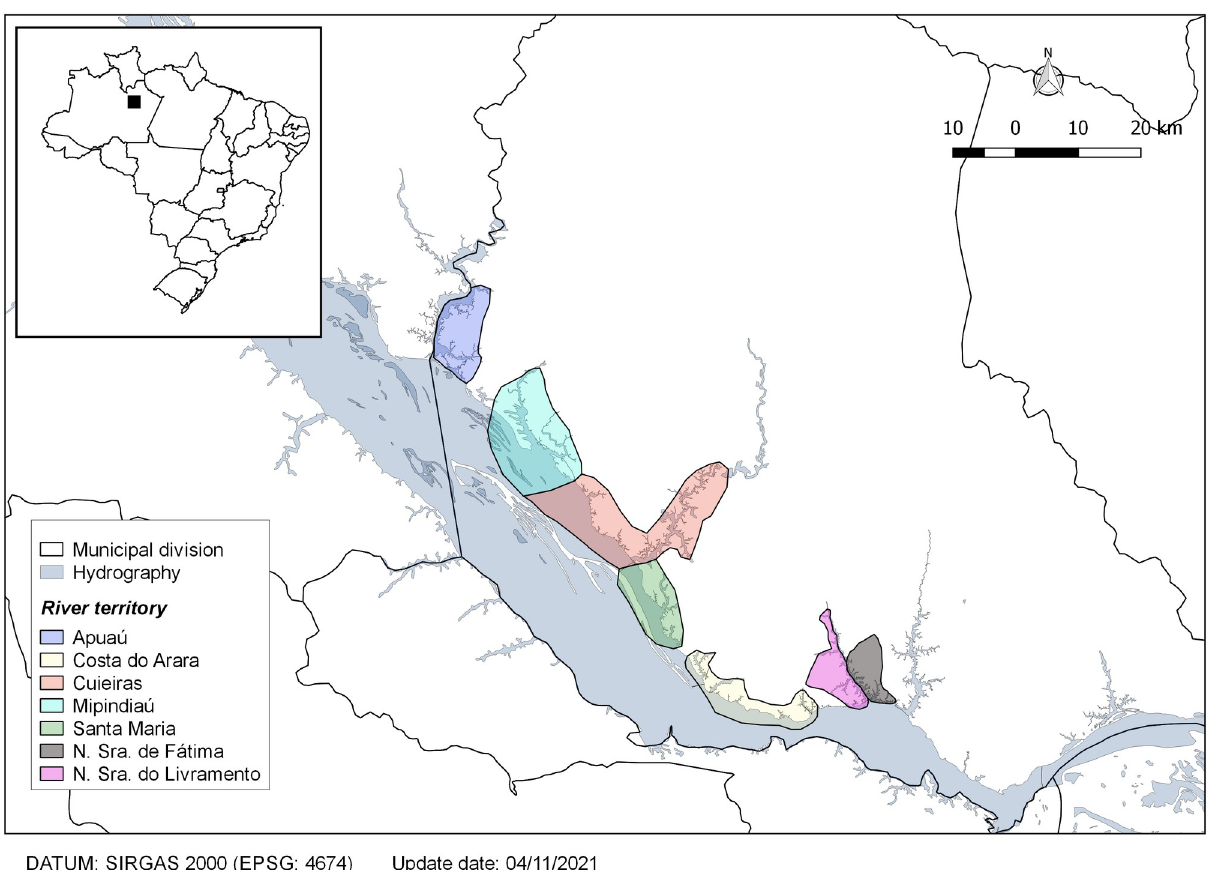
Fig 1. Territories covered by the fluvial and riverside health teams. Municipal division data were obtained from Instituto Brasileiro de Geografia e Estatı´stica, IBGE (public domain): https://www.ibge.gov.br/en/geosciences/territorial-organization/territorial-meshes/ and hydrography data were obtained from Instituto Nacional de Pesquisas Espaciais, INPE (public domain):